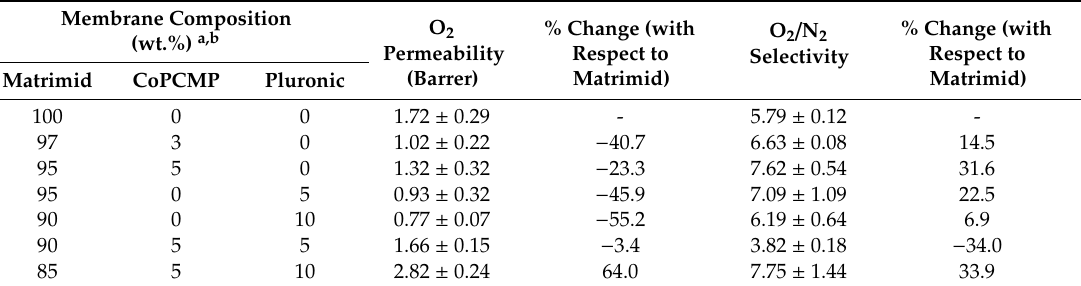
Table 1. O 2 / N 2 gas permeation behavior of neat (Matrimid), blended (Matrimid-Pluronic), and composite (Matrimid-CoPCMP and Matrimid-CoPCMP-Pluronic) membranes at 35 ◦ C under 1 bar (21 / 79 vol / vol) O 2 / N 2 feed